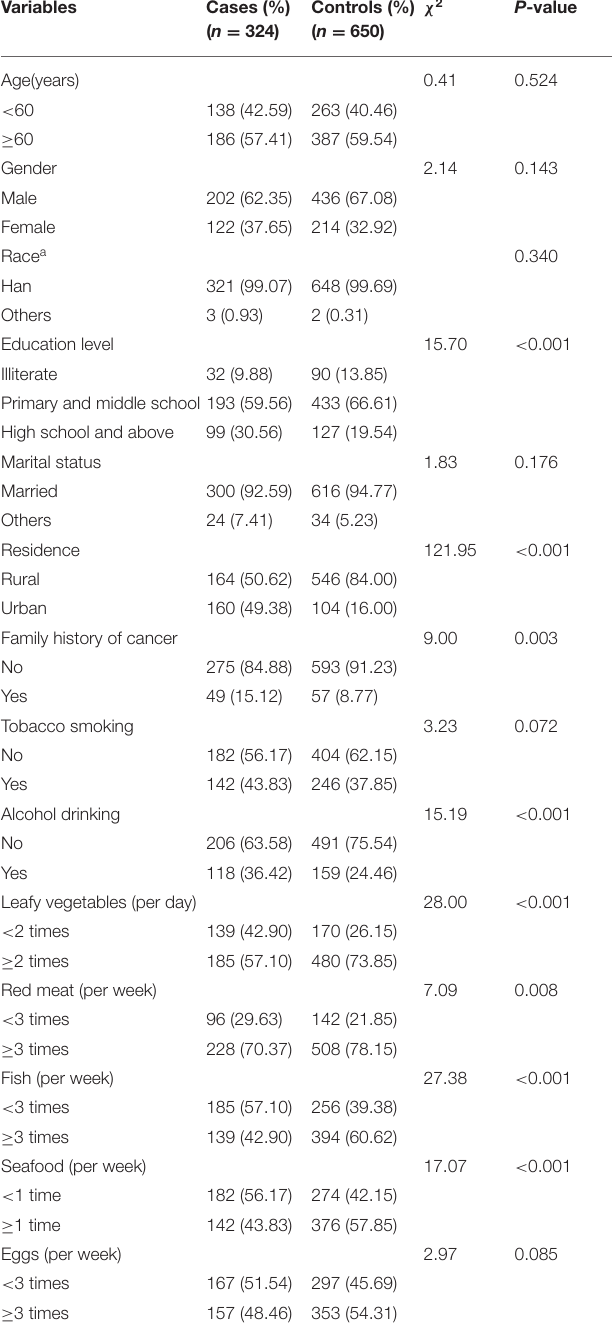
TABLE 1 | Distribution of selected characteristics among patients with oral cancer and controls.